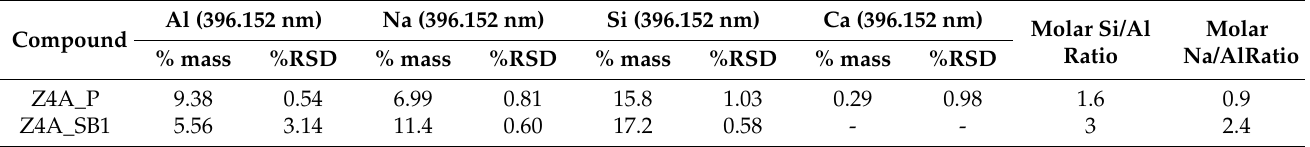
Table 3. ICP-AES analysis results for the 4A zeolite